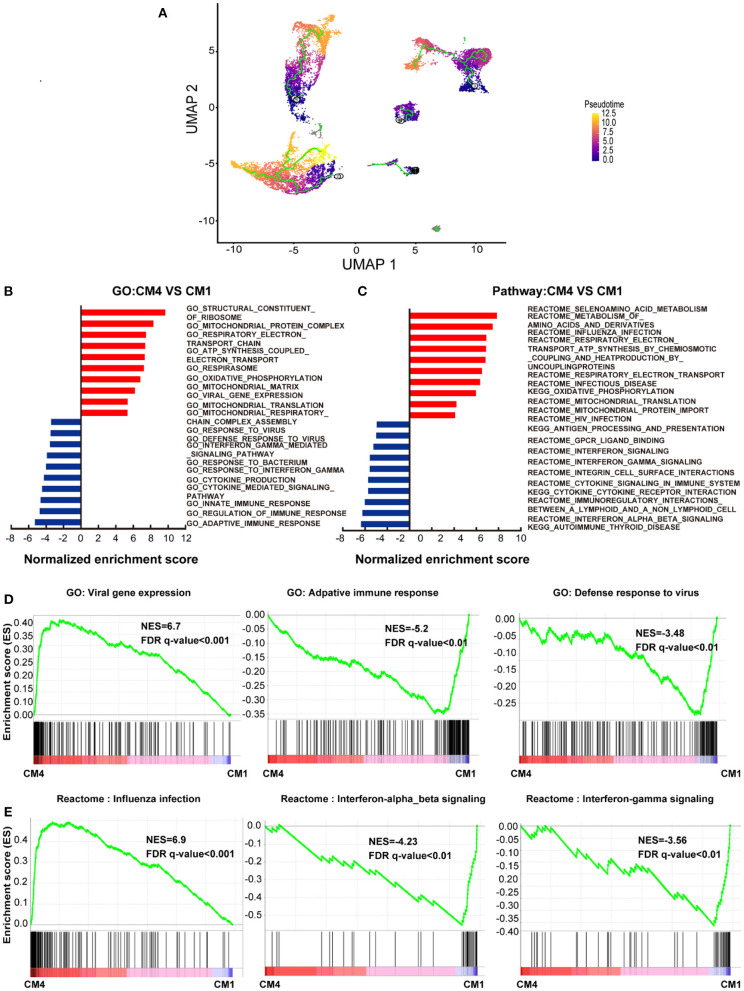
Cardiomyocytes 4 (CM4) shows different characteristics with Cardiomyocytes 1(CM1). (A) Pseudotime analysis of the nine clusters, the color from purple to yellow denote the different developing stage, and the simultaneous principal curve indicates the pseudo-time stage. (B,C) GSEA analysis revealed significant enrichment of GO and pathways for CM4 compared with CM1. (D) GO enrichment showing GO terms of increased viral gene expression, decreased adaptive immune response, and defense response to virus. (E) Influenza infection signaling pathway is up-regulated, both interferon-alpha-beta signaling and interferon-gamma signaling are down-regulated.